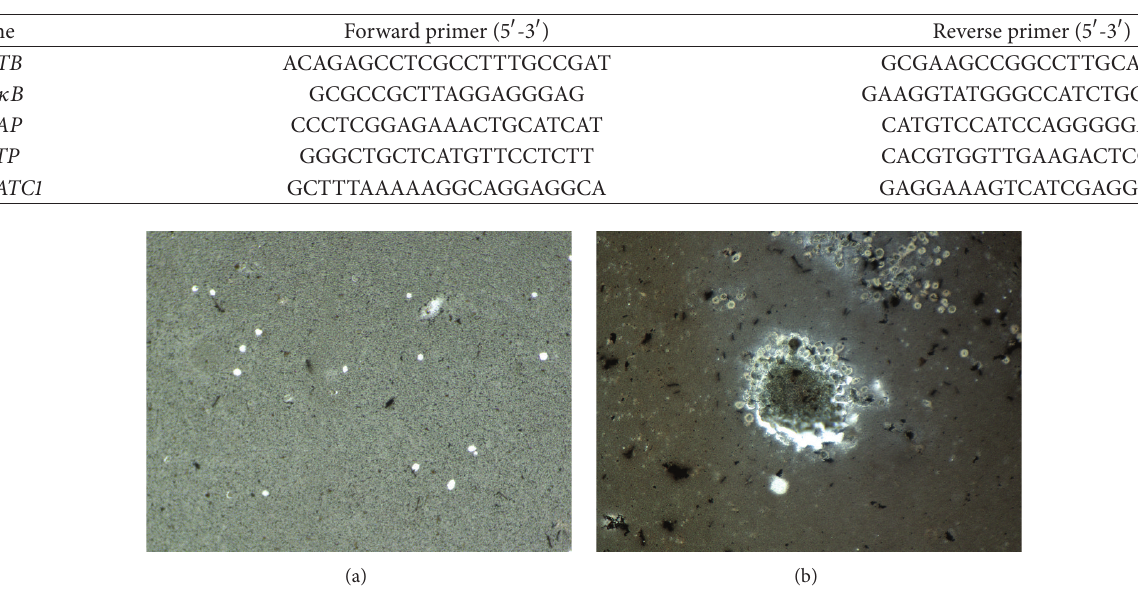
Figure 1: Depicted are two exemplary fields of view of the von Kossa-stained calcium phosphate plate. The pictures were taken of samples that were not stimulated with pantoprazole, 7 days after differentiation. Multiple resorption zones (white spots) where osteoclasts were located prior to lysis are visible at 20x magnification (a). A large cluster of osteoclasts is visible in the middle of the picture with several smaller clusters in the periphery of the picture at 10x magnification